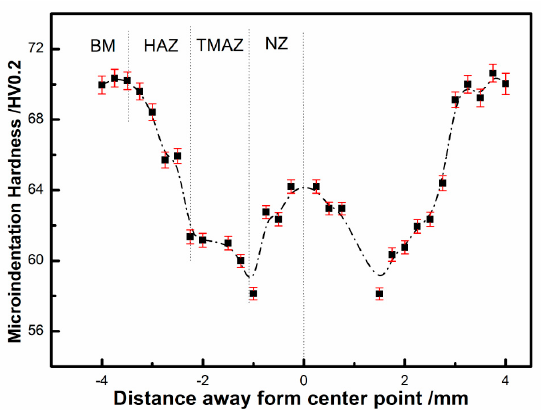
Figure 5. Variation of microindentation hardness along the length direction, resenting a W-shaped profile which is symmetrical to the NZ.